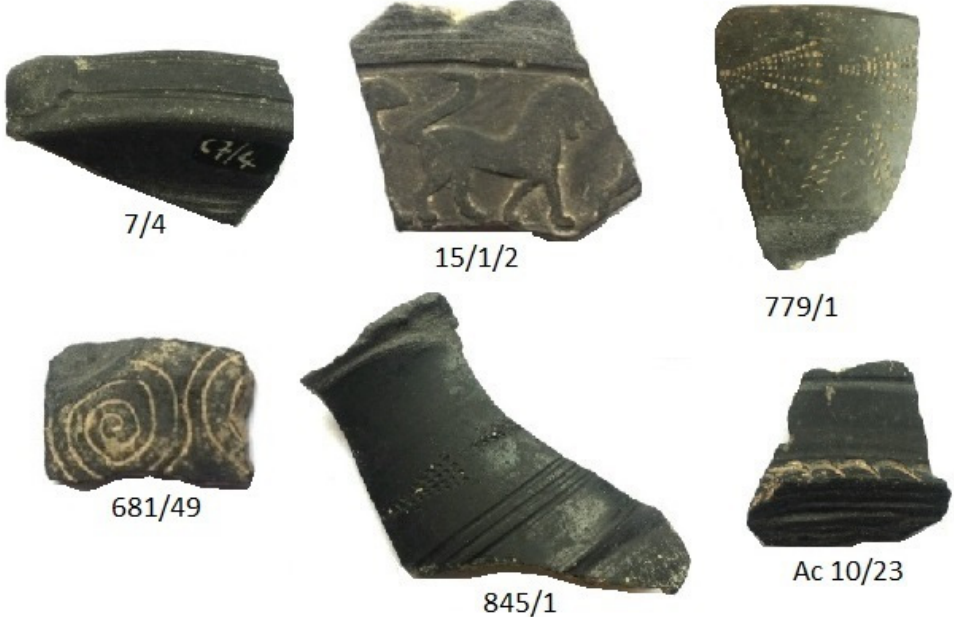
Figure 2. Examples of bucchero fragments from the excavation of La Civita di Tarquinia. Refer to Table 1 for the inventory numbers. Table 1. Bucchero samples from the excavation of La Civita di Tarquinia. For each sample, the inventory number, the codex of the ceramic paste (see Table 2) and the chronology are reported. Legend: n.d. = not determined.